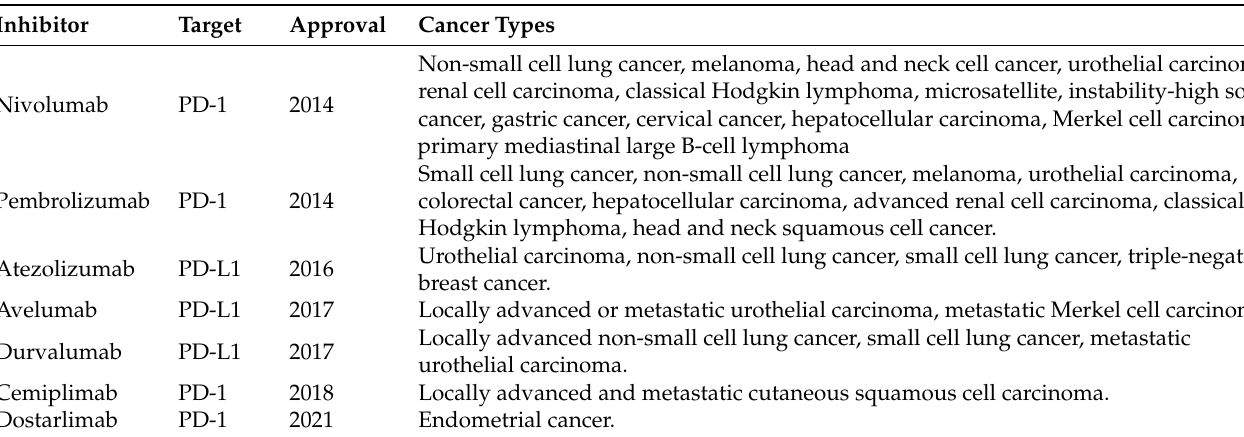
Table 1. FDA-approved PD-L1/PD-1 blocking antibodies.